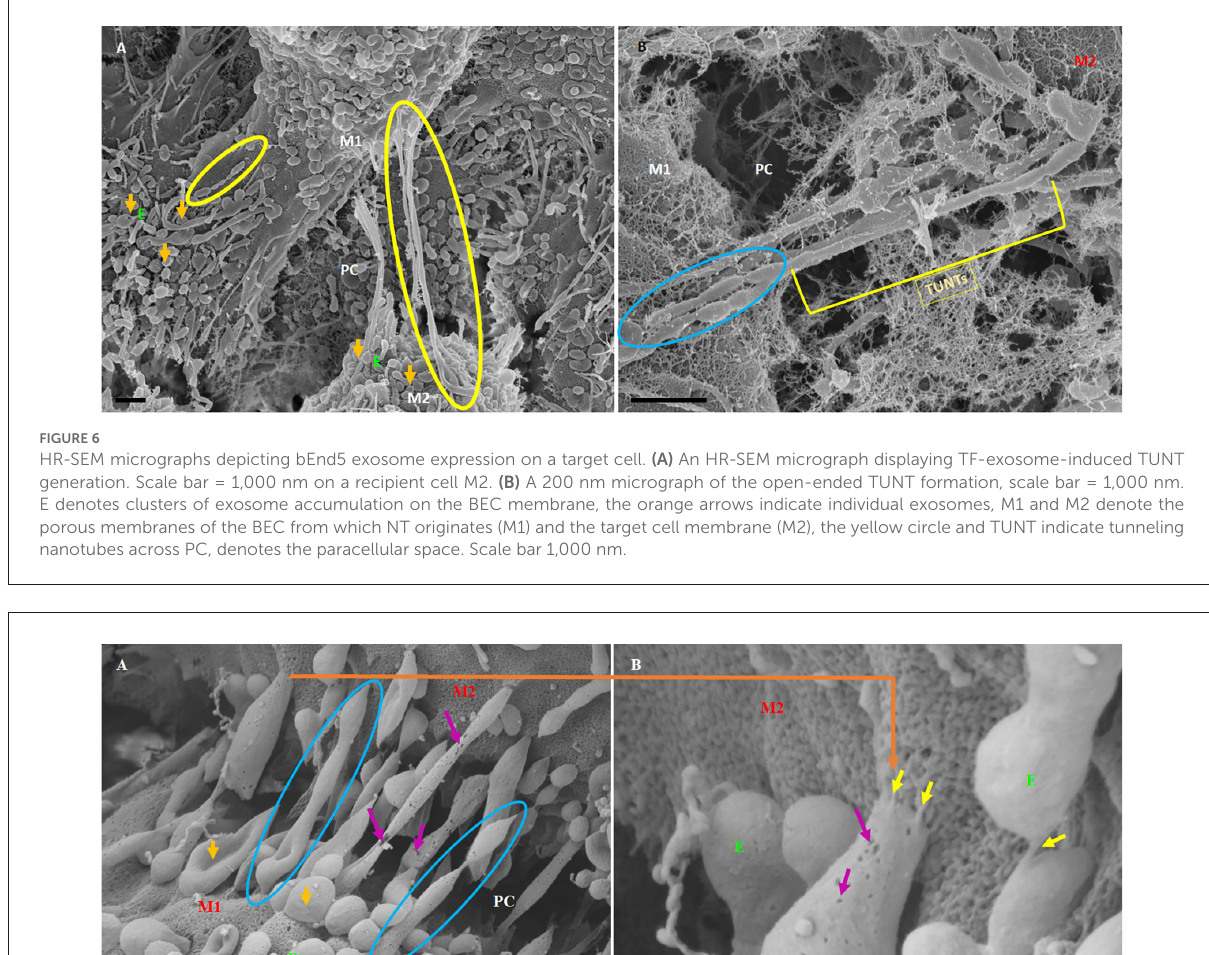
manner, thus there is no dominant cell as both cells are working simultaneously in